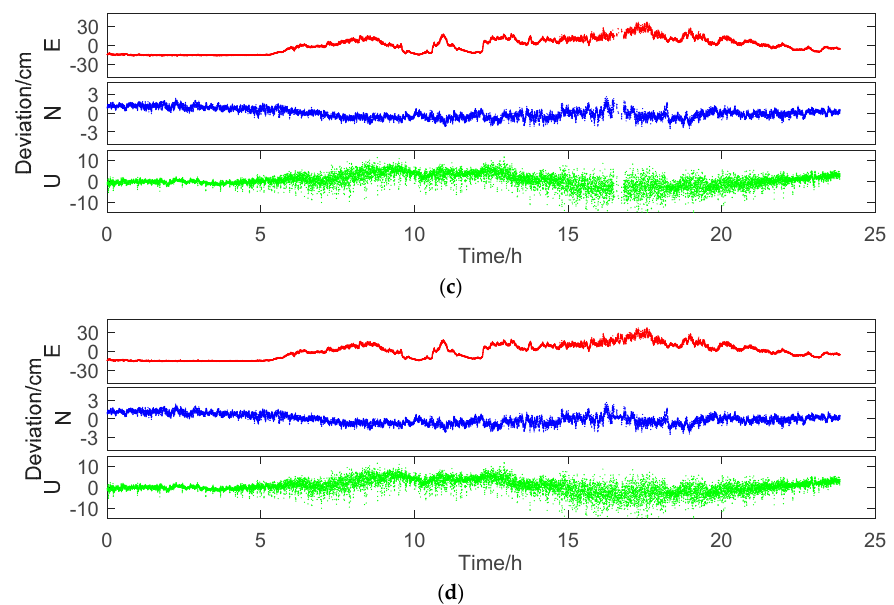
Figure 7. Position deviation of different strategies for baseline shm1-shm2: ( a ) GPS, ( b ) C-GPS, ( c ) GPS/Galileo, and ( d ) C-GPS/Galileo.